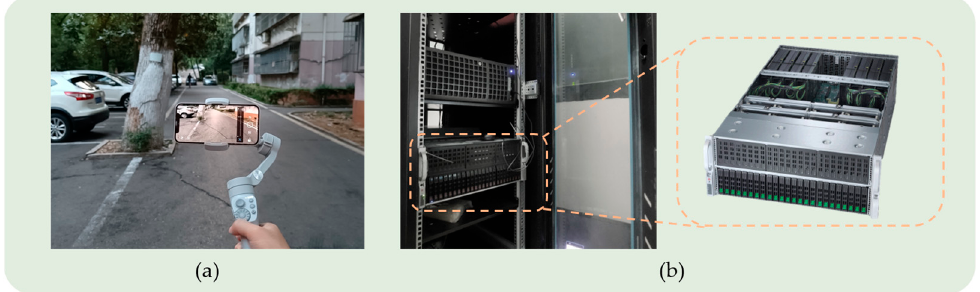
Figure 10. Devices for image collection and network training: ( a ) Handheld Gimbal: Feiyu Vimble 3; and ( b ) Deep learning server: Super Cloud R8428 G11.